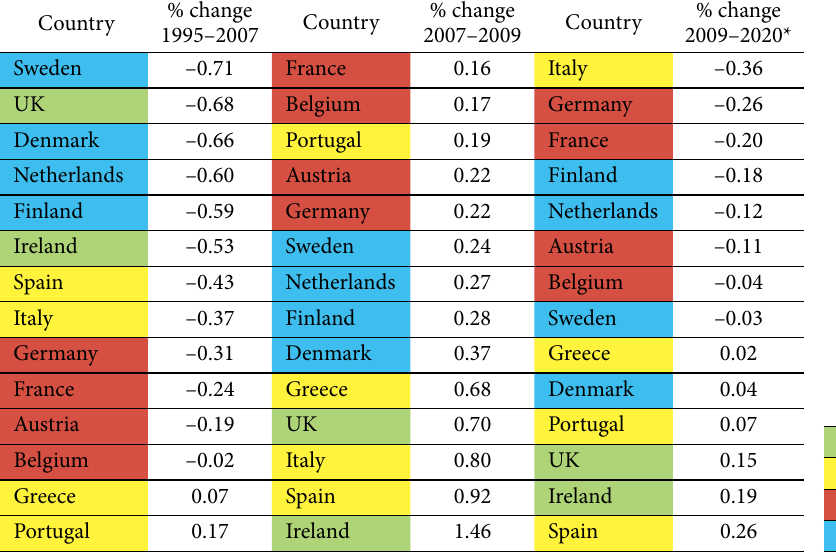
Table 5. The change of social public expenditure for unemployment benefits in % of GDP, EU–15